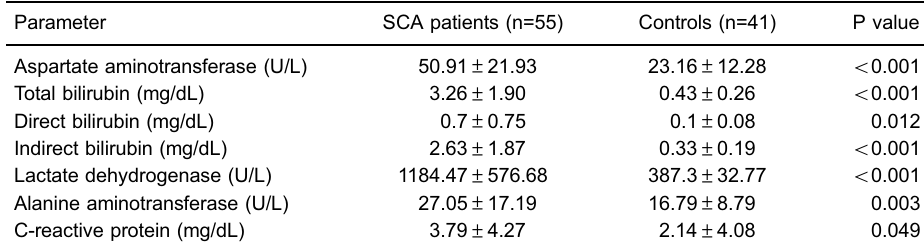
Table 3. Biochemical characteristics of the study